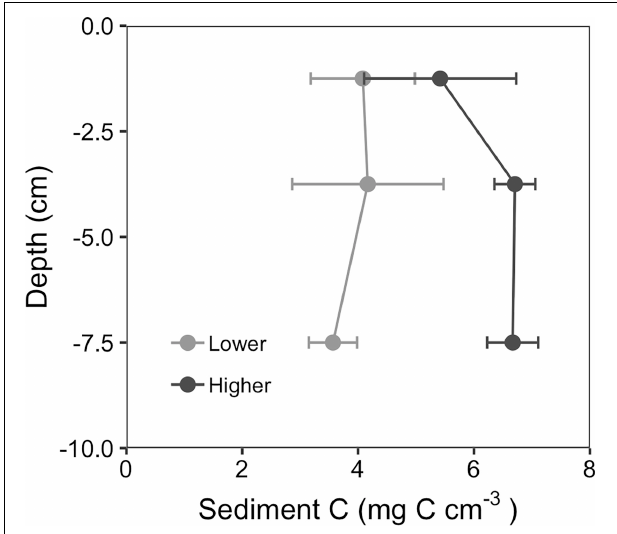
FIGURE 7 | Depth profiles of sediment carbon content showed that in 2018, 3 years after the MHW disturbance, higher recovery sites retained more carbon at depths below the surface compared to lower recovery sites. Values are mean ± 2 × SE, n = 3.